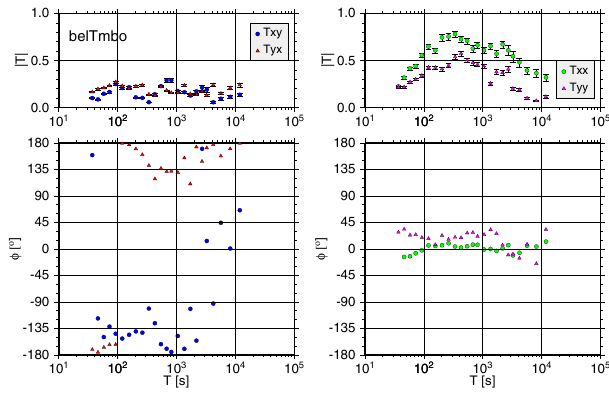
Figure 8. Inter-station transfer function between BEL (Poland) and MBO (Senegal) for 101 days of